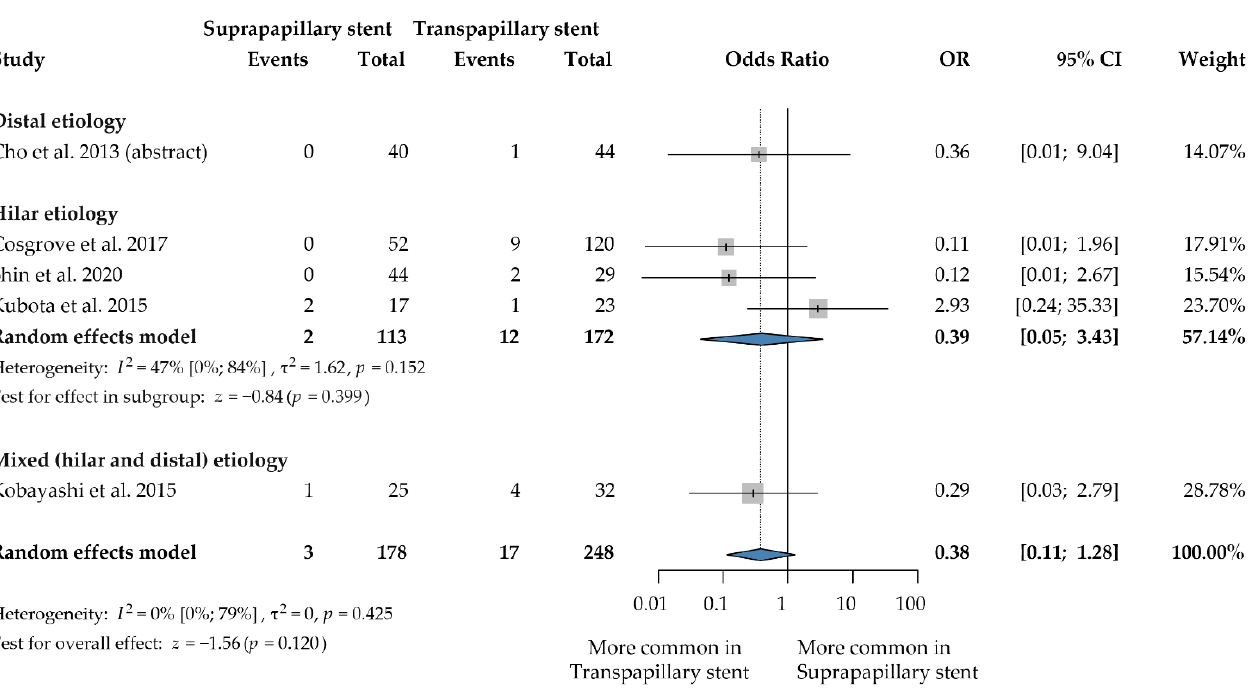
Figure 5. Forest plot comparing pancreatitis rate between suprapapillary and transpapillary stents. OR: odds ratio, p: P-value; CI: confidence interval; I-squared: I 2 . [23,25 – 28]